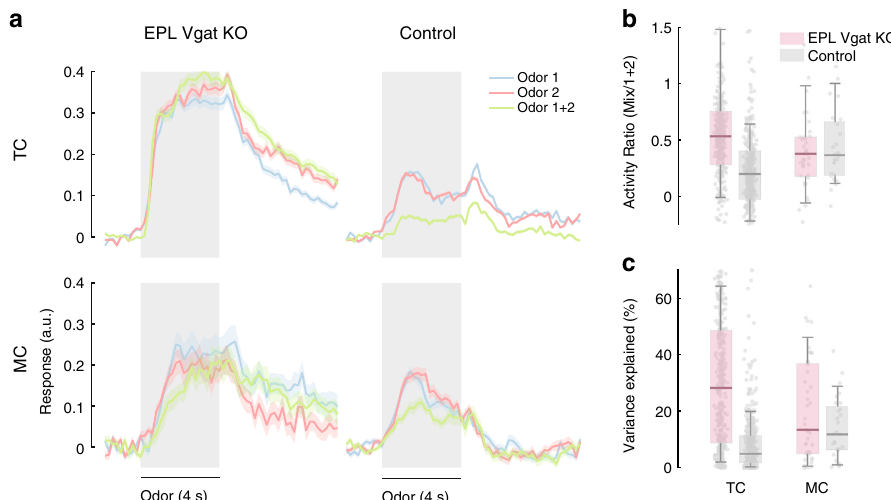
Fig. 7 Responses to odor mixtures become more linearly predictable without EPL-IN. a Average TC and MC calcium responses from experimental and control animals to 2 odorants and their mixtures. Error bands indicate SEM. b Ratios between the response to odor mixtures, and the sum of the responses to the constituent odorants. Responses represent the average response pro fi le 6s (includes both ON and OFF responses) from odorant onset. c % Variance explained of a linear regression model built to predict the responses to odor mixtures from the responses to single odors. For b , c Box plots are computed across all cell- odor pairs — bounds of the box span from 25 to 75% percentile, center line represents median, and whiskers visualize 10 and 90% of the data points. The number of cells for EPL Vgat KO animals: TC = 357, MC = 41, for control animals: TC = 407, MC = 28. *** p <0.001, Wilcoxon rank sum